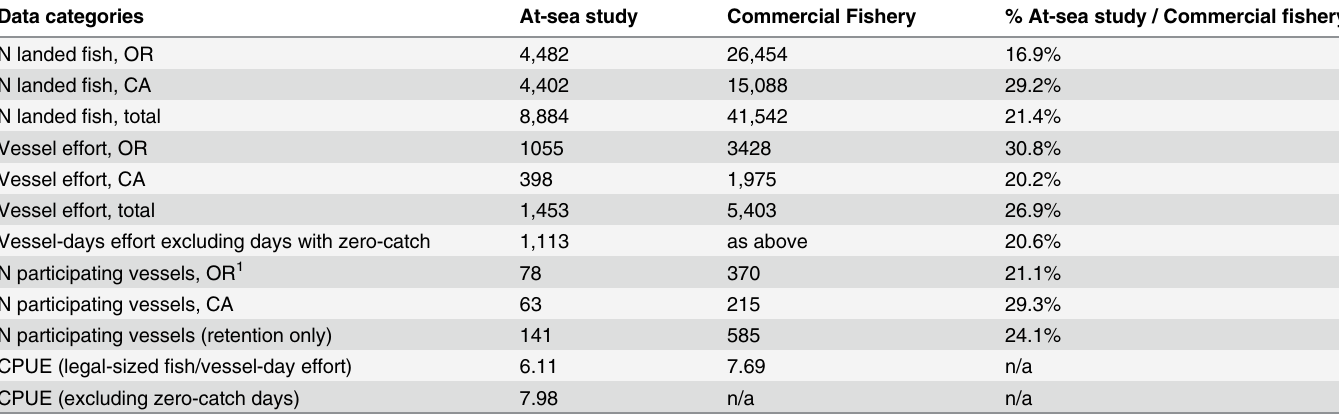
Table 4. Comparison between at-sea study and 2010 commercial fishery data. Data